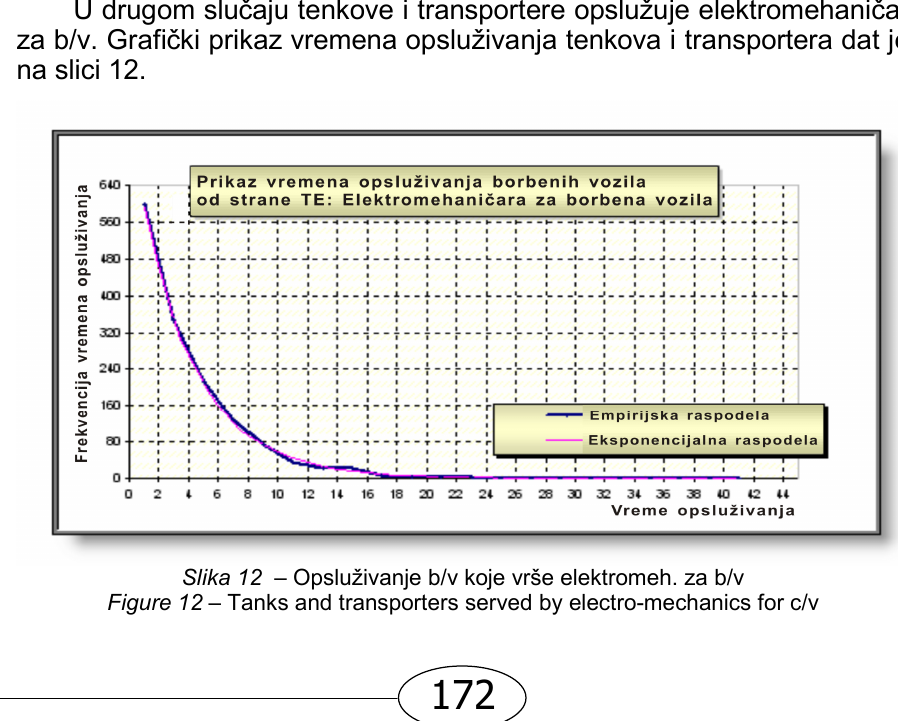
Slika 11 – Opsluživanje b/v koje vrše meh. za b/v Figure 11 – Tanks and transporters served by mechanics for c/v Uz primenu hipoteze o slaganju empirijske i pretpostavljene teorijske raspodele, utvr đ eno je da se empirijska raspodela ne može složiti sa ne- kom od poznatih teorijskih